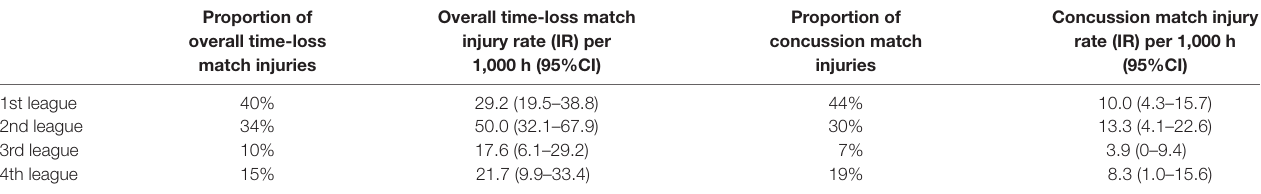
TABLE 4 | Exposure time, number, proportion, IR (95%CI), and match injury rate of overall ( n = 89) and concussion ( n = 27) injuries, by